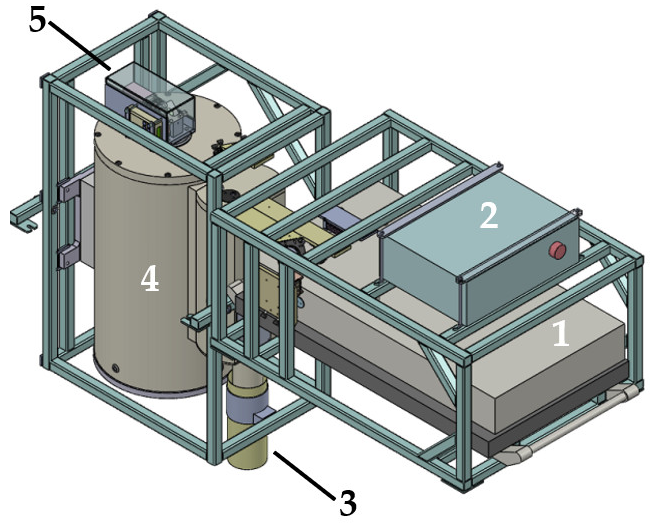
Figure 4. Model of the modernized airborne lidar for atmospheric methane monitoring: laser (1); laser power unit (2); off-axis mirror collimator (3); Cassegrain telescope (4); photodetector unit (5).